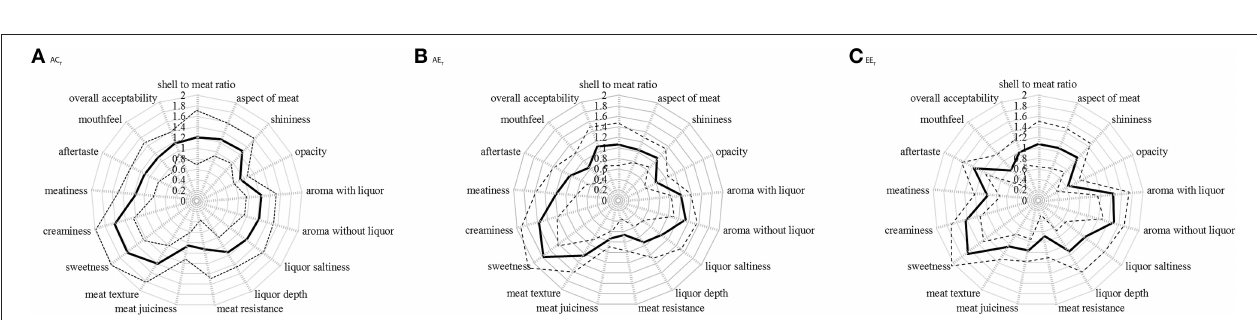
FIGURE 2 | Mean score attributed by the panelists to each of the 17 oyster attributes ( n = 9 oysters per treatment). Continuous line: Ambient p CO 2 & control temperature; Dashed line: Ambient p CO 2 & elevated temperature; Dotted line: Elevated p CO 2 & elevated temperature. The scales ranged from 0 (optimum score 0) to 3 (least favorable score).